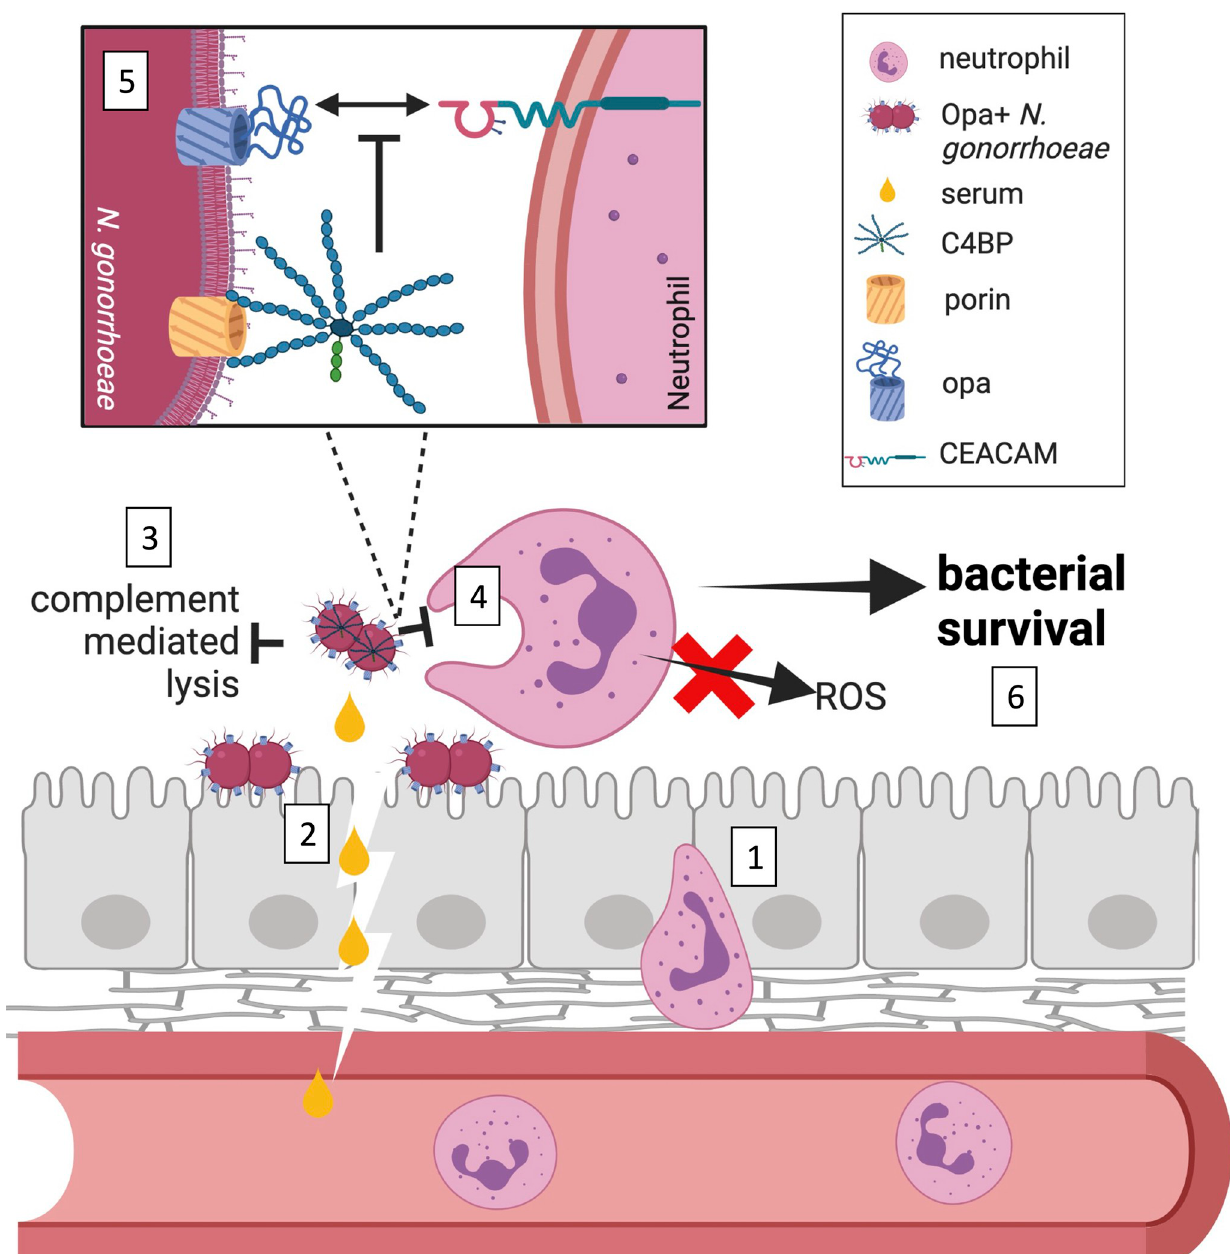
Fig 7. C4BP in gonococcal pathogenesis. Neutrophils are recruited to mucosal sites of Neisseria gonorrhoeae infection by extravasating from the blood stream and crossing the epithelia paracellularly (1). Inflammatory conditions of the infection as well as serum transudate bring N . gonorrhoeae into contact with C4b-binding protein (C4BP) (2). The ability of N . gonorrhoeae to bind to C4BP to inhibit complement-mediated lysis has been extensively documented (3). This work shows that C4BP that is bound to the surface of N . gonorrhoeae decreases phagocytic uptake by neutrophils and suppresses neutrophil reactive oxygen species (ROS) production, in a complement-independent manner (4). C4BP binding decreases the interaction of CEACAM- binding, opacity protein (Opa)-expressing N . gonorrhoeae with neutrophils, but not bacteria that are opsonized with IgG or that express Opa proteins that engage other ligands (5). As a consequence, C4BP enhances survival of N . gonorrhoeae from neutrophils, a novel function for this canonical complement inhibitor (6). Figure generated using Biorender (https://biorender.com/).